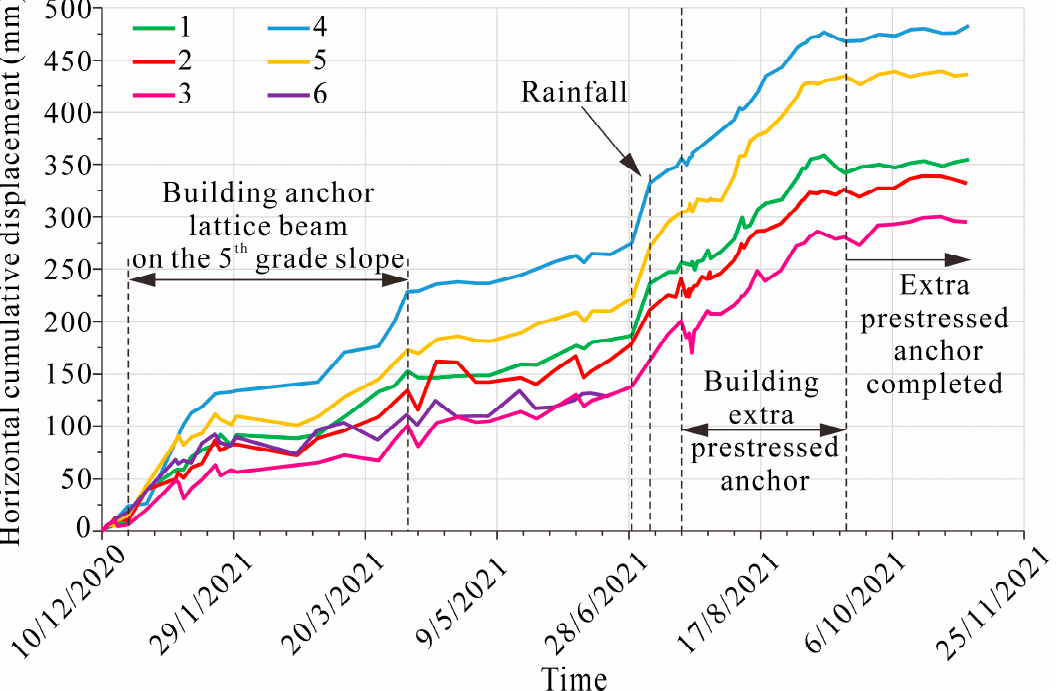
Figure 6. Horizontal cumulative displacement of the Anling landslide.